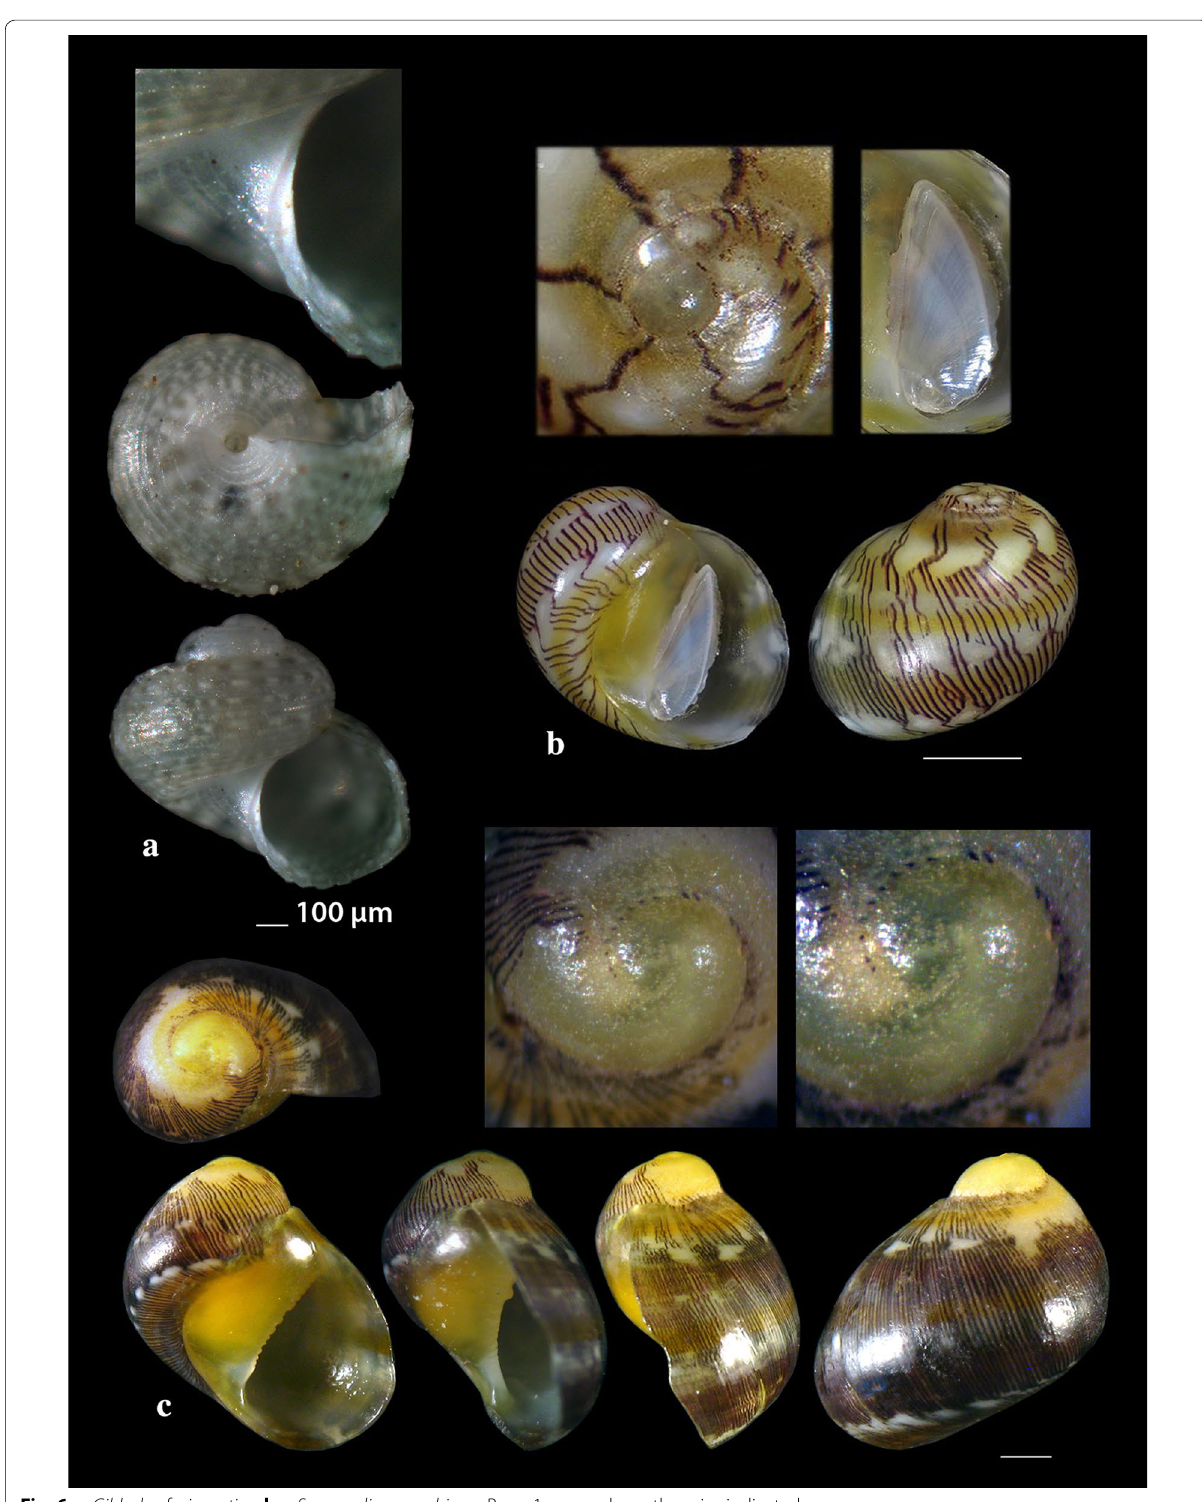
Fig. 6 a Gibbula cf. vimontiae , b , c Smaragdia souverbiana. Bar